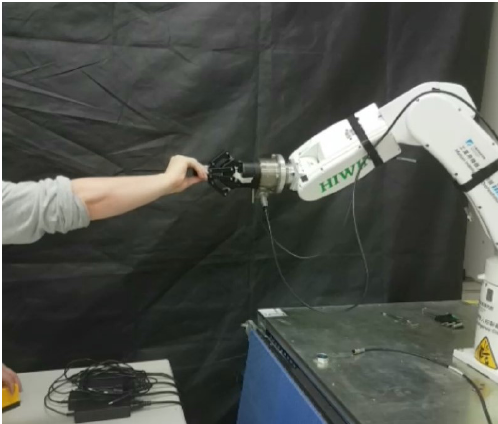
Figure 4. Experimental setup used for the tests showing the robot equipped with the force/torque (F/T) sensor and a gripper on the